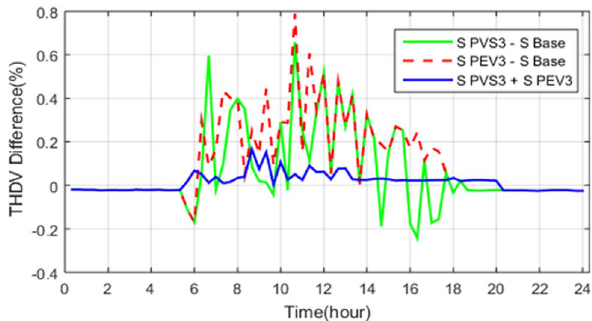
Figure 18. Analysis of daily pro fi les of THD difference when zero value of medium voltage grid and PEV harmonic compared to base case.